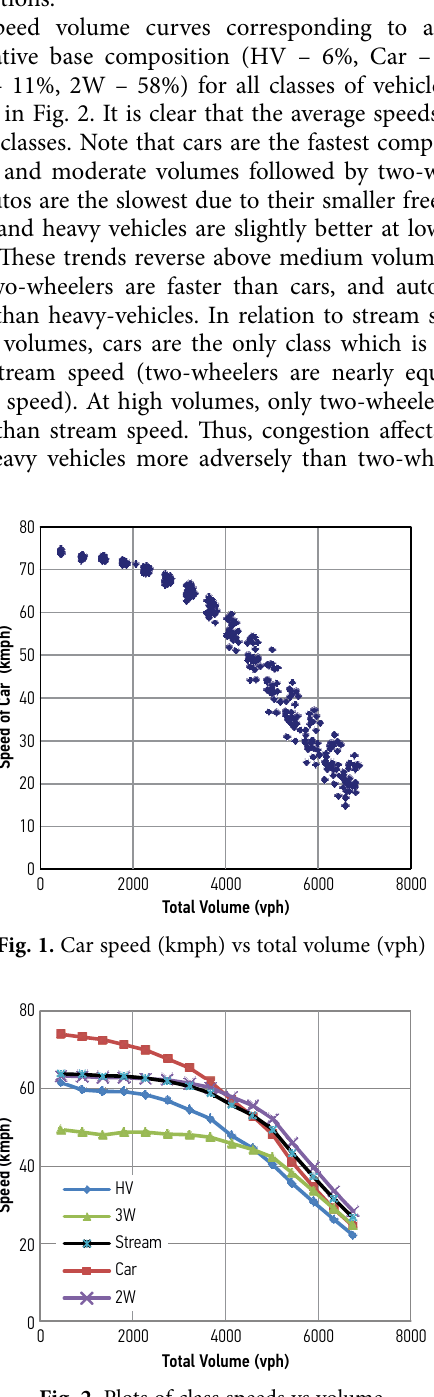
Fig. 2. Plots of class speeds vs